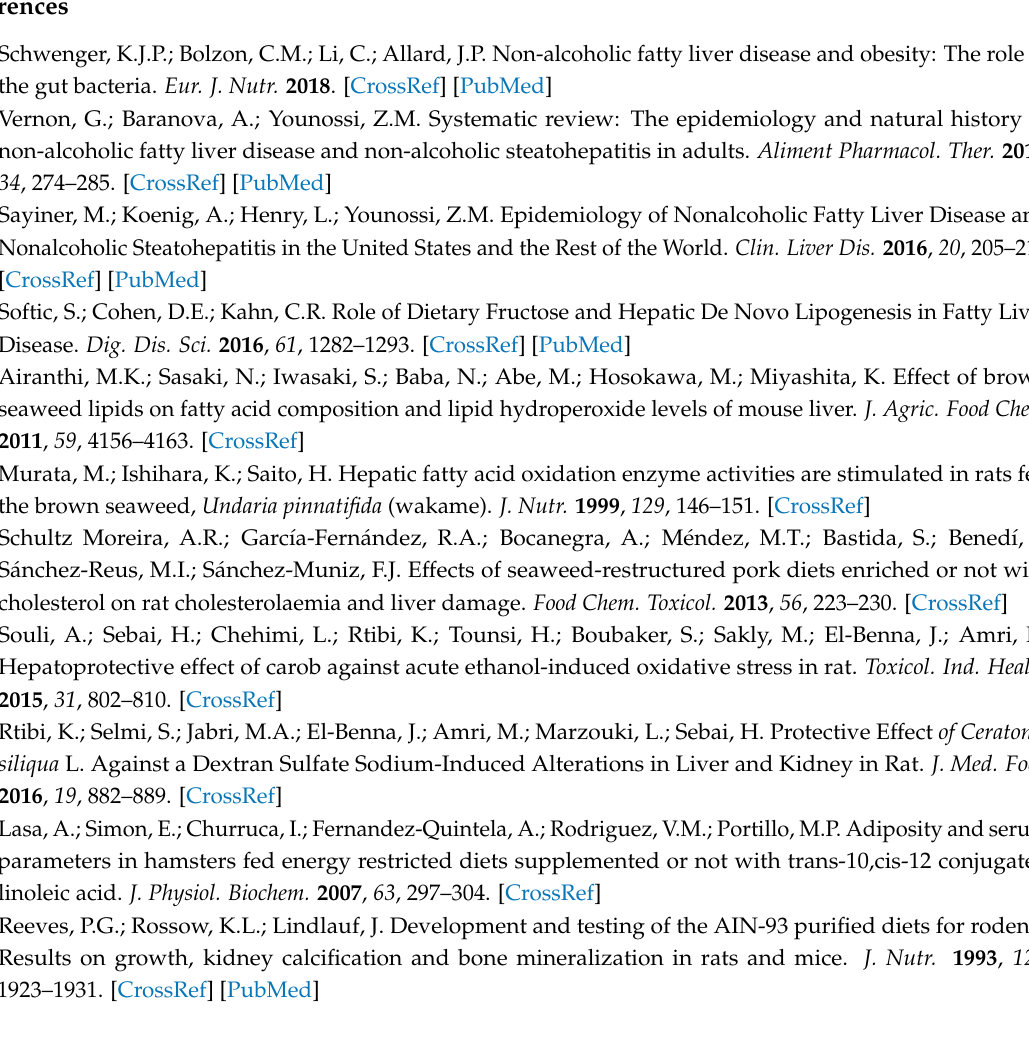
Figure S1: Flowchart of the experimental